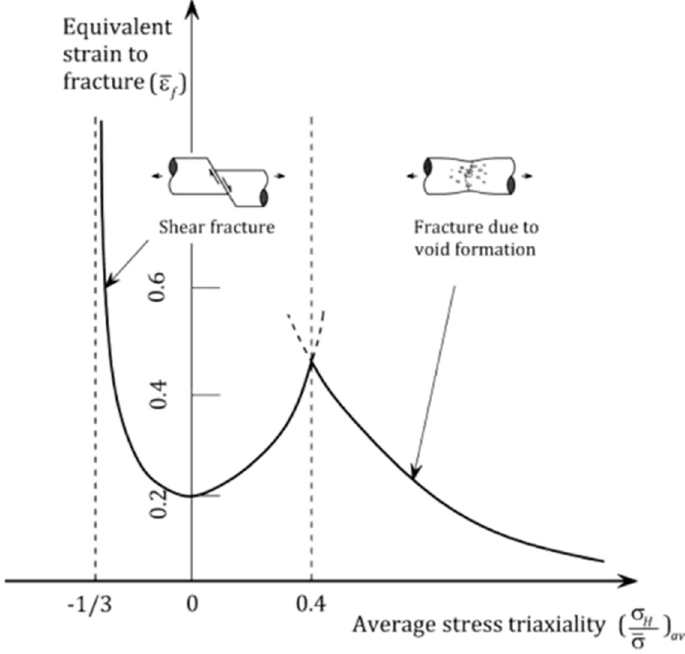
Figure 1. Fracture locus: failure strain vs. average stress triaxiality [5].